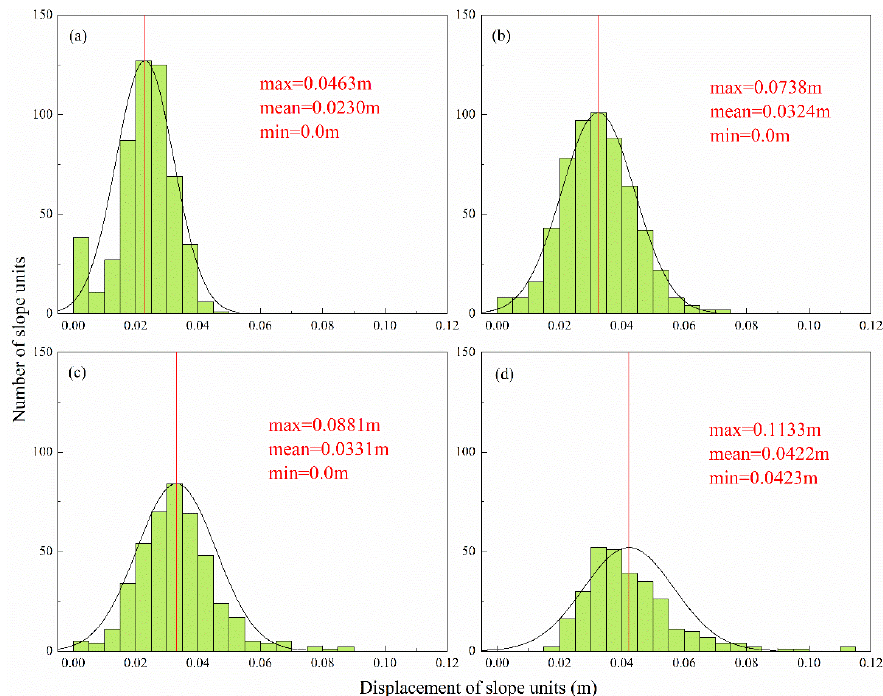
Figure 11. Distribution histogram of the number and LOS displacement values of slope units in different hazard levels: ( a ) low hazard; ( b ) moderate hazard; ( c ) high hazard; and ( d ) very high hazard. The red lines represent the average displacement values in different hazard levels.